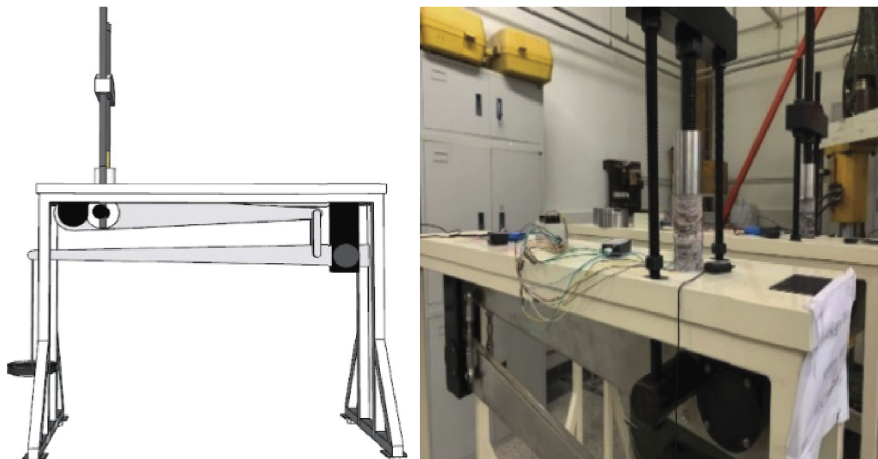
Figure 14: Rock time-effect loading